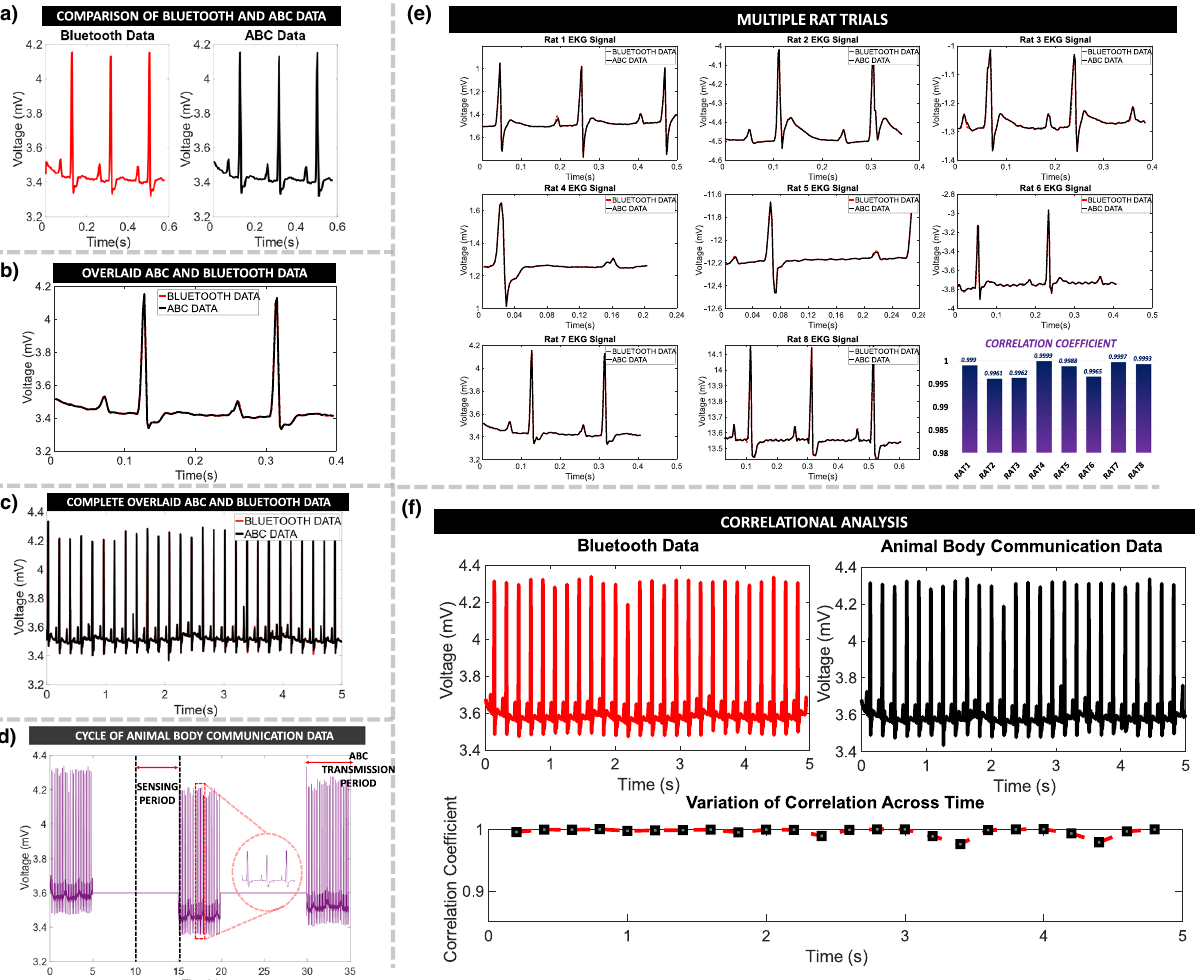
Figure 6. Rat Electrocardiogram (EKG) Analysis: ( a ) Bluetooth and ABC transmitted signal. ( b ) Overlaid Bluetooth and ABC transmitted signal data, depicting overlap of the EKG peaks. ( c ) Complete 5s Bluetooth and ABC transmitted EKG Signal. ( d ) Time multiplexed ABC transmission cycles, 5s transmission time followed by a 10s wait time to allow for Bluetooth transmission and next cycle sensing. ( e ) Overlaid plots of EKG Signals from eight rats with correlational analysis between Bluetooth and ABC transmitted signals. ( f ) Time varying correlational analysis of one 5s sensing cycle of rat EKG